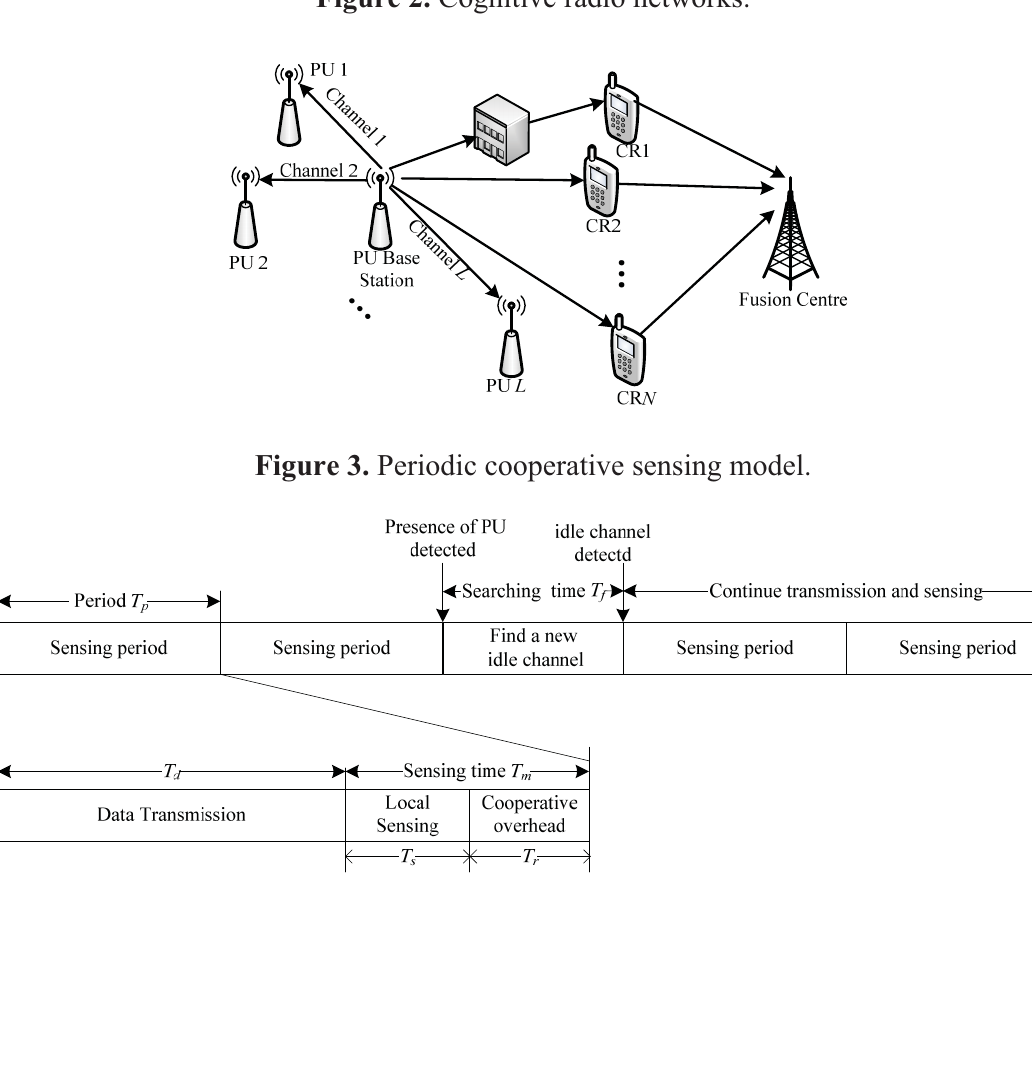
Figure 2. Cognitive radio networks.